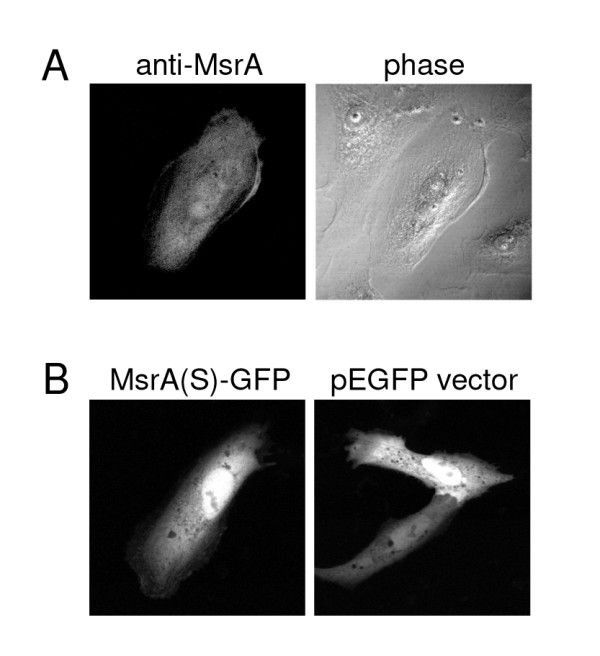
Subcellular localization of the MsrA(S) form. (A) The MsrA(S) expression construct (pMsrA(S)ΔGFP) was transfected into monkey kidney CV-1 cells. Transfected cells were stained with anti-MsrA antibodies followed by secondary anti-rabbit Cy5-conjugated antibodies. A set of two images is shown: left panel, immunofluorescence; right panel, phase contrast. (B) Green fluorescence images of CV-1 cells expressing GFP-fused MsrA(S) (left) and control proteins (pEGFP vector, right).